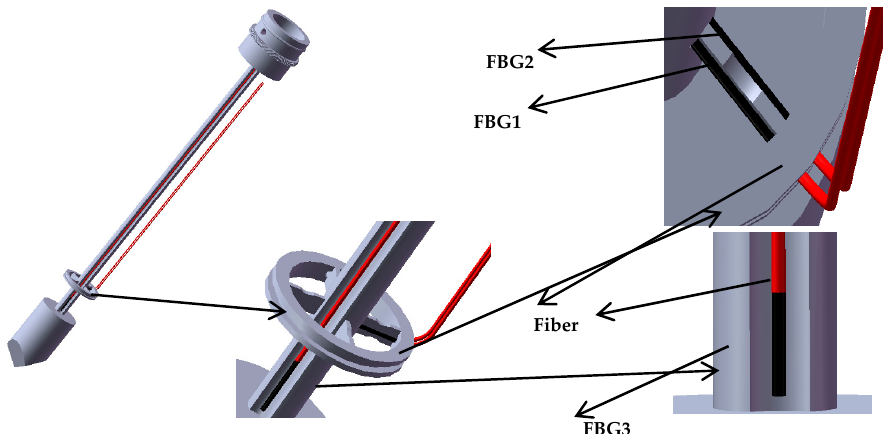
Figure 9. Three groups of FBGs paste position. FBG1 and FBG2 are pasted on the upper and lower surfaces of the new type of elastic beam, while FBG3 is pasted in groove on the surface of the puncture needle